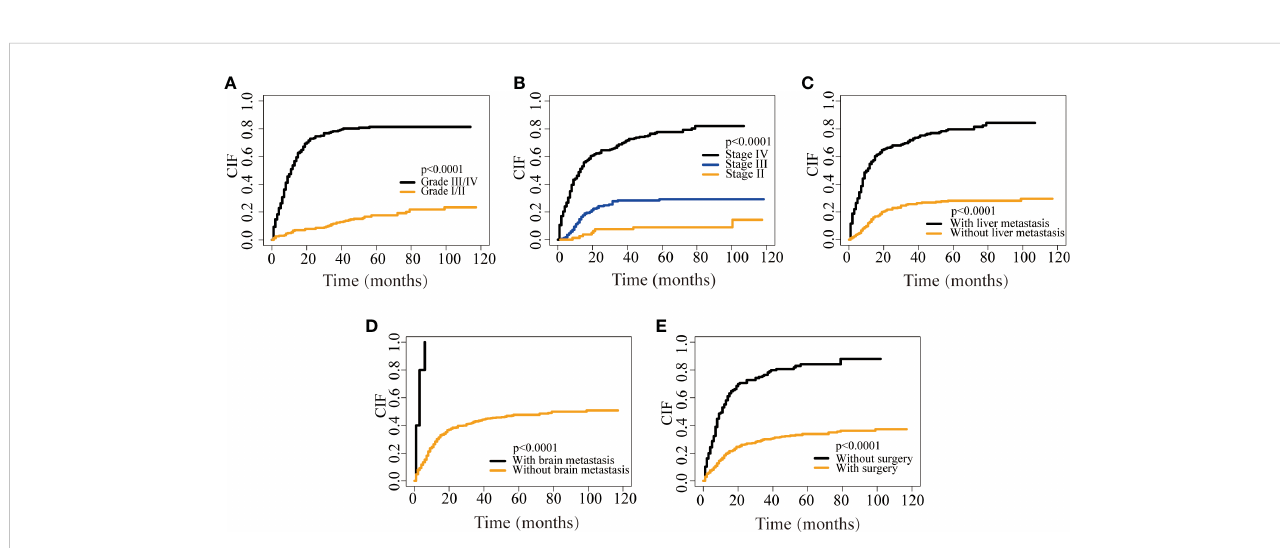
FIGURE 4 CIF curves depicting CRNENs-caused death based on grade (A) , stage (B) , liver metastasis (C) , brain metastasis (D) , and surgery (E) . CRNENs, colorectal neuroendocrine neoplasms; CIF, cumulative incidence function.